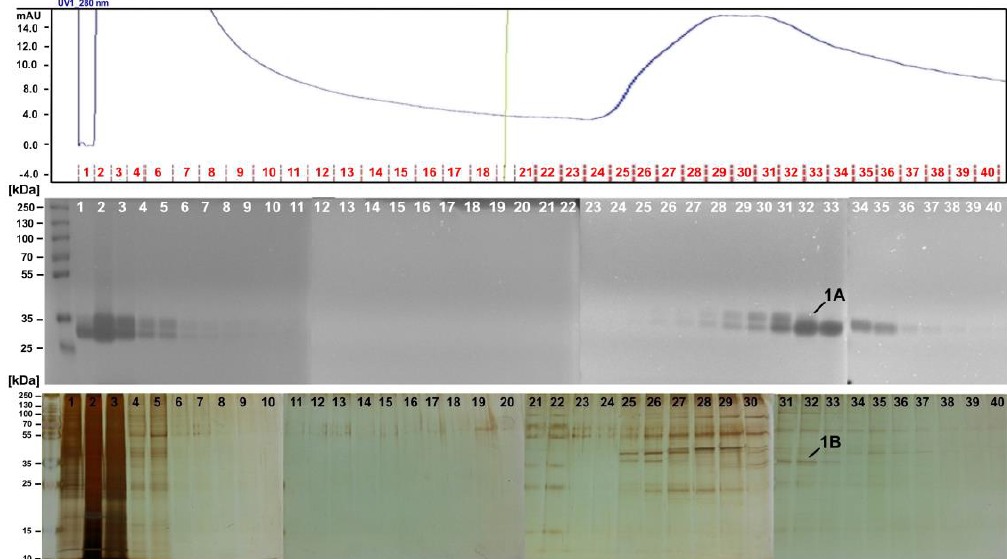
Figure 2. Fractionation of C. majus whole plant extract on a heparin column. Top: Absorbance at 280 nm—blue line— indicates protein content in fractions. Red lines and numbers represent fraction numbers. Middle: In-gel DNase assay zymography of protein fractions with high nucleolytic activity. Band 1A of ca. MW 33–35 kDa was cut, and MLP presence was confirmed by MS/MS. Bottom: Protein profiles of each fraction in SDS-PAGE stained with silver. Band 1B of ca. MW 36 kDa was cut from the gel, and MLP presence was confirmed by